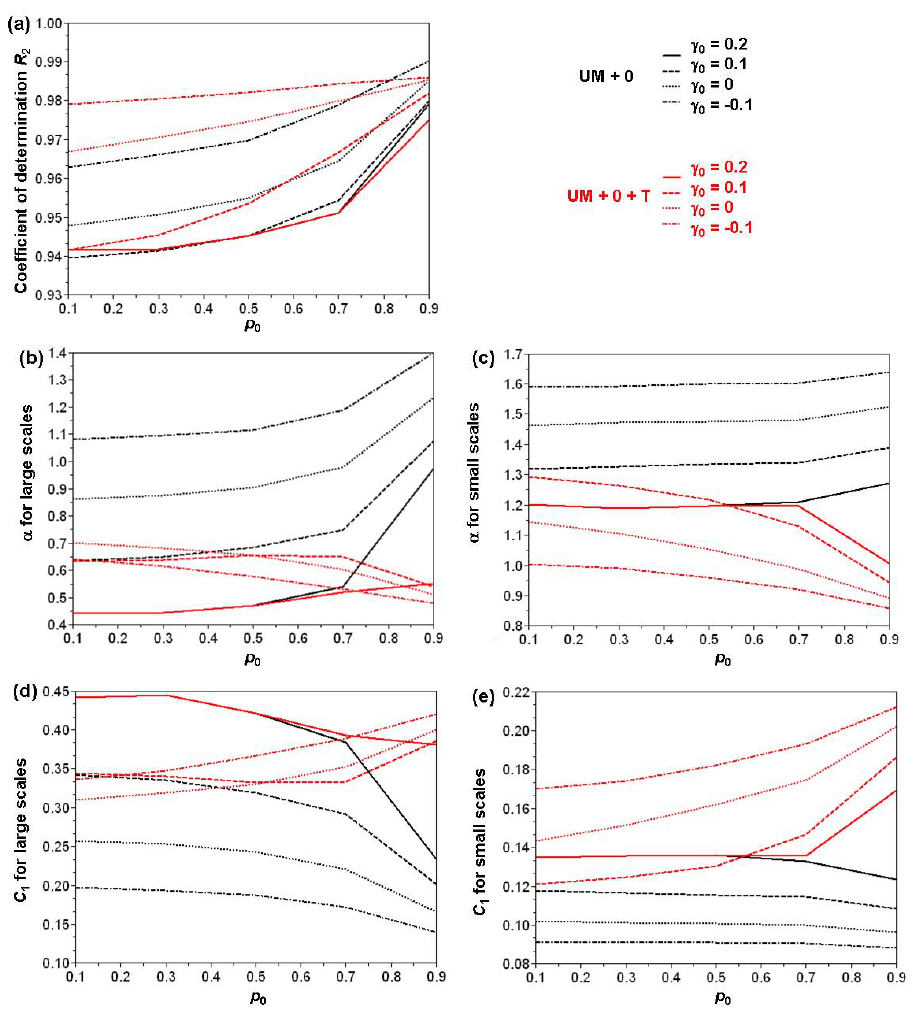
Fig. 7. Analysis of the sensitivity to γ 0 and p 0 : coefficient of determination R 2 of the linear regression in the TM analysis for q = 2 (a) , α and C 1 for large and small scales (b, c, d, e) .